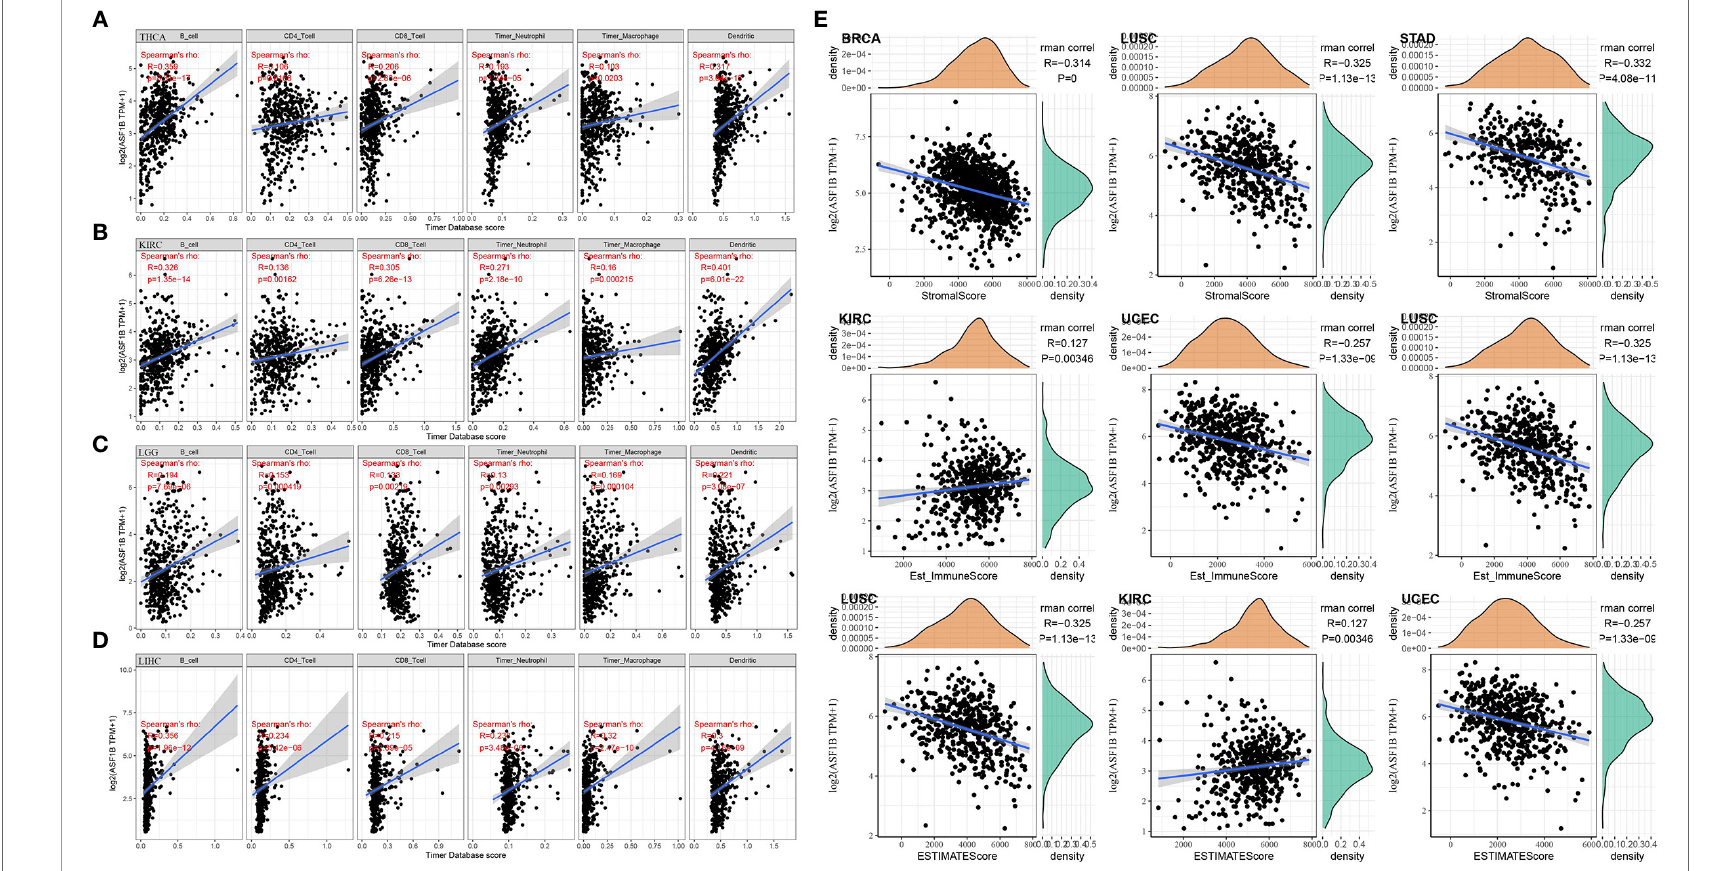
FIGURE 5 | Correlation of ASF1B with tumor immune in fi ltration and the tumor microenvironment in THCA and other cancers; (A) Correlation of ASF1B expression with immune cell in fi ltration in THCA; (B) Correlation of ASF1B expression with immune cell in fi ltration in KIRC; (C) Correlation of ASF1B expression with immune cell in fi ltration in LGG; (D) Correlation of ASF1B expression with immune cell in fi ltration in LIHC; (E) Correlation of ASF1B with the immune score, stromal score, and ESTIMATE score in